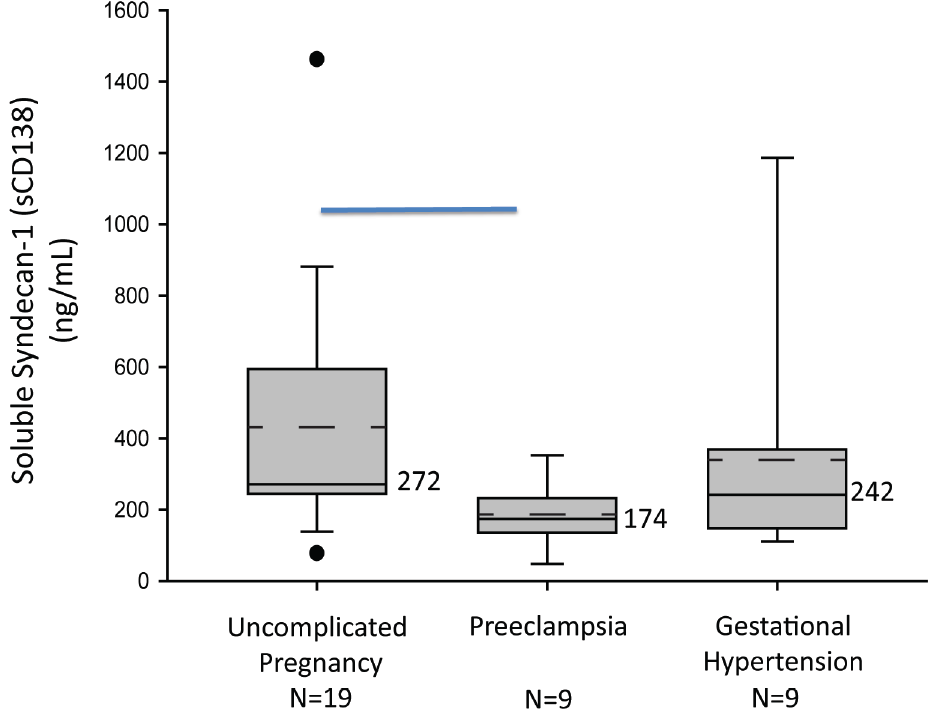
Fig 2. Plasma soluble Sdc1 is reduced at 20 weeks gestation in women who later develop preeclampsia. Box-plot of soluble Sdc1 concentrations in mid-pregnancy maternal plasma by pregnancy outcome group. The solid line through the interior of each box and the accompanying numerical value corresponds to the group median. The dotted line through the interior of each box denotes arithmetic mean. The top and bottom of each box correspond to 75 th and 25 th percentiles, respectively. The whiskers (t bars) on the bottom denote the 10 th percentile, and those on the top the 90 th percentile. Solid circles represent outlier values. The horizontal line, on the top of the graph indicate significant difference between control and preeclampsia groups (P < 0.05; Kruskal-Wallis with Dunn ’ s Post-hoc